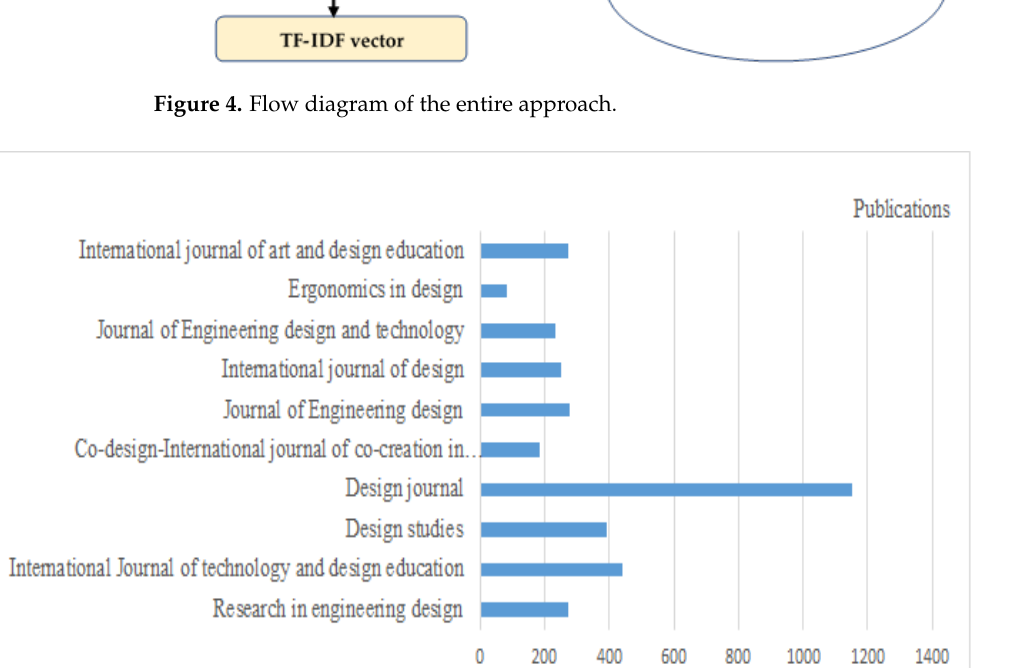
Figure 5. Distribution of publication per journal.